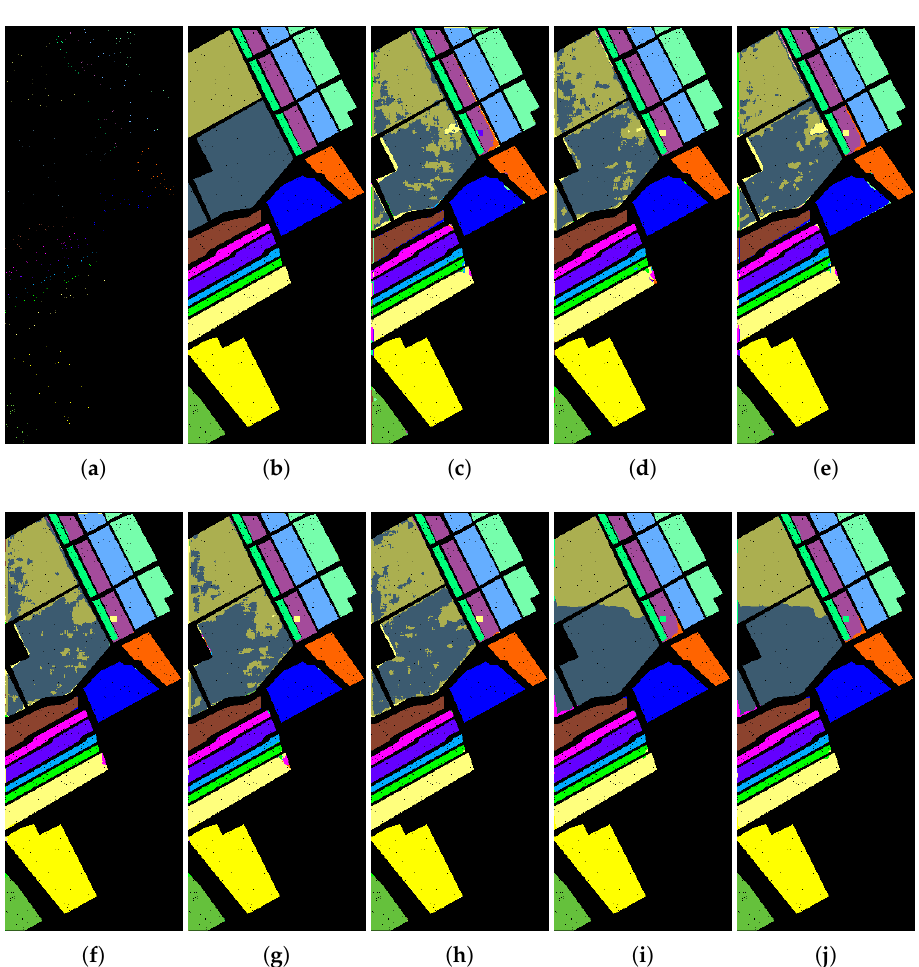
Figure 9. Classification maps of different DR models based on SVM on the Salinas data with the Ground Truths (GTs) corresponding to the training and testing data. ( a ) Training GT. ( b ) Testing GT. ( c ) SVM. ( d ) SPPCA. ( e ) NWFE. ( f ) SLGDA. ( g ) LapCGDA. ( h ) LGSFA. ( i ) SaCGDA. ( j )